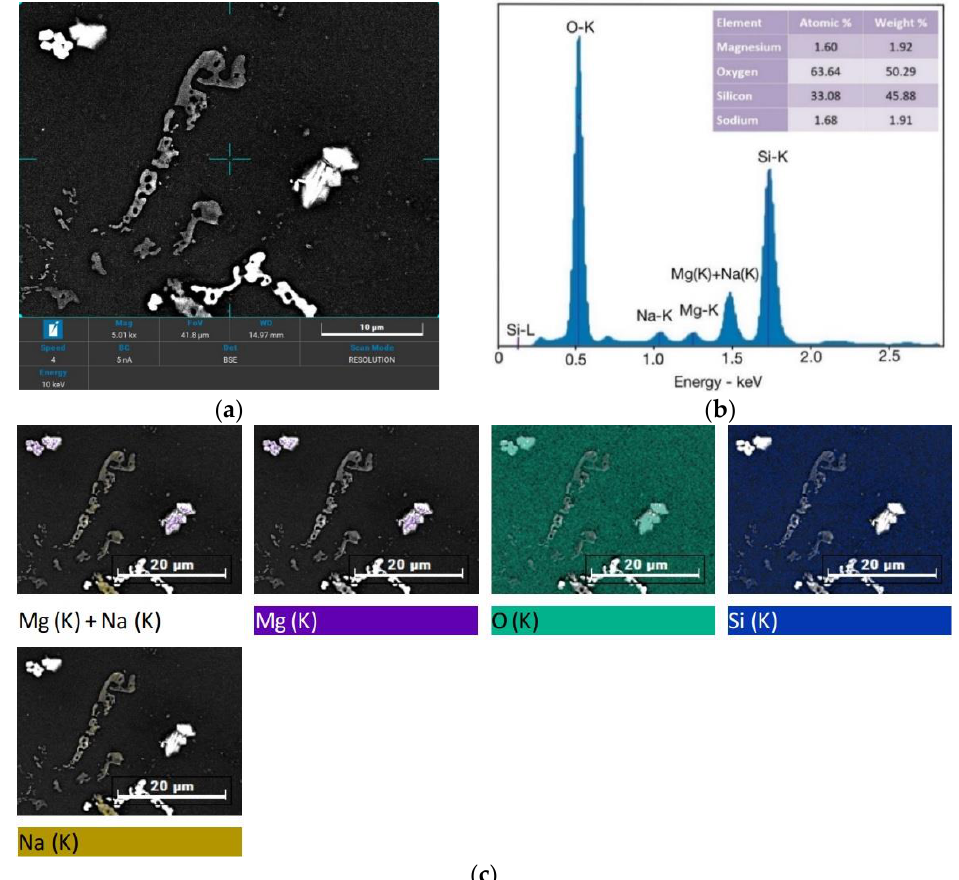
Figure 15. SEM and EDS of porcelain insulators with normal coatings. ( a ) SEM image of surface; ( b ) The EDS-spectrum and quantity analysis; ( c ) The element images.